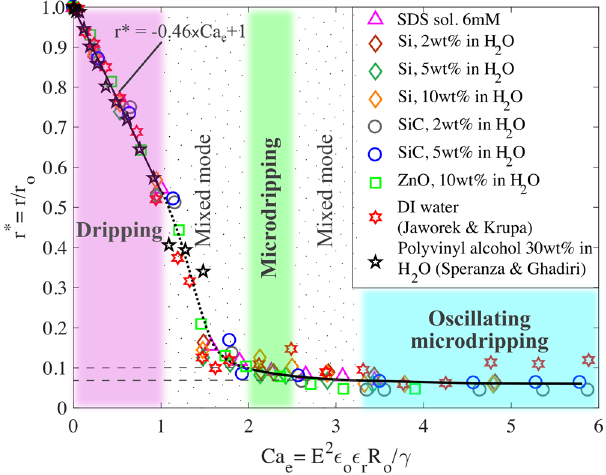
Figure 4. Dimensionless size of droplets vs electric capillary number. Results from Fig. 3a,b are nondimensionalized with respect to the droplet radius in the absence of electric field and displayed as a function of the electric capillary number. Transition between dripping and microdripping modes occurs at Ca e ≈ 1.0 and the transition between microdripping and oscillating microdripping modes occurs at Ca e ≈ 2.5. The modes are color coded corresponding to Fig.